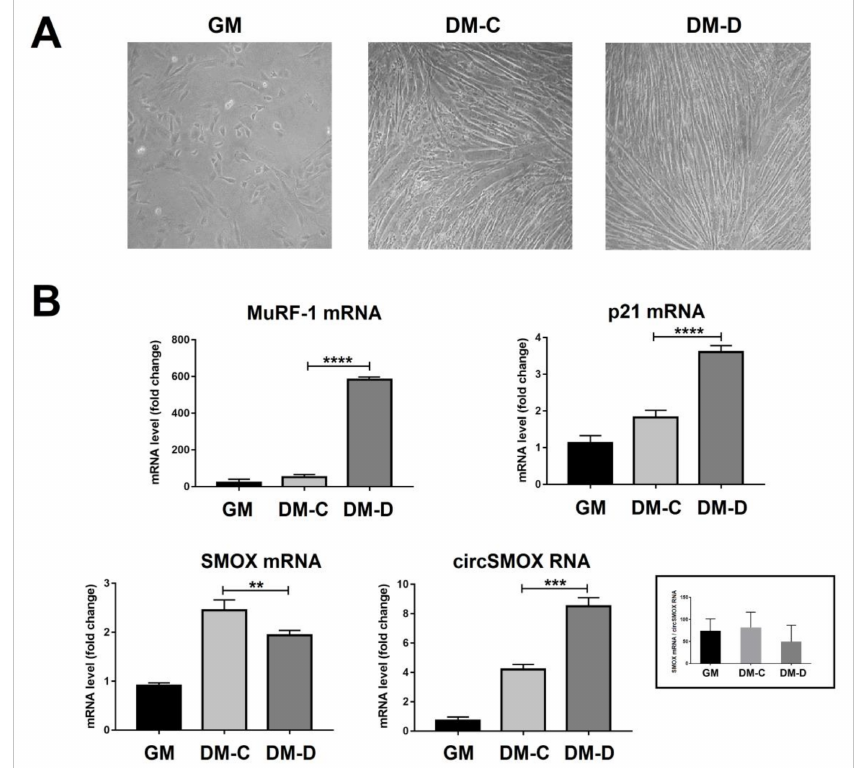
Figure 4. Linear and circular SMOX RNAs expression in atrophic C2C12 cells. ( A ). Microscopic analysis of C2C12 cells cultured on growth medium for 48 h (GM, myoblasts) were di ff erentiated for 120 h (DM-C, untreated myotubes) or di ff erentiated for 96 h and then treated with DEXA 100 µ M for 24 h to induce atrophic condition (DM-D, treated myotubes). ( B ). qRT-PCR of MuRF-1 and p21 mRNAs (B) and of linear and circular SMOX RNAs (D) from GM, DM-C and DM-D. Data are calculated relative to the internal housekeeping gene (GAPDH) and are expressed as the mean fold change compared with GM control. Each value represents the mean ± SD of three independent experiments, each performed in triplicate. One-way ANOVA, followed by Bonferroni’s test, were used to determine significant